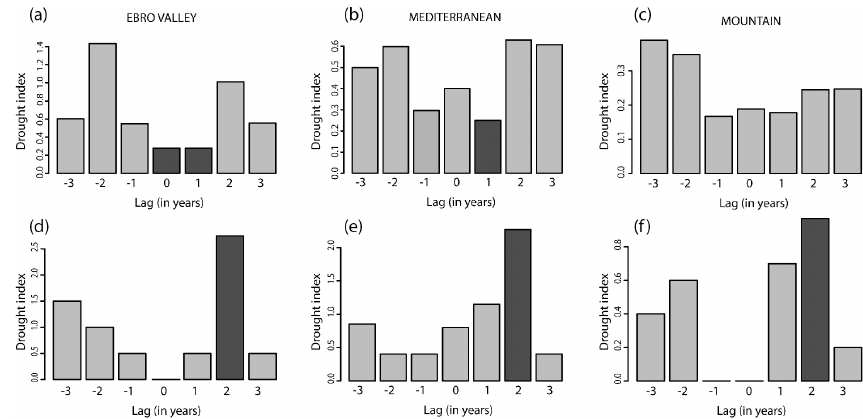
Figure 8. (a, b, c) Superposed epoch analysis (SEA) of the three regional drought indices, DIMOU (Mountain), DIEV (Ebro Valley) and DIMED (Mediterranean), with major volcanic events from Sigl et al. (2015). Black shadows show significance at p <0.01, i.e., significantly lower or higher drought index values after the volcanic event. (d, e, f) SEA of only the Tambora (1815) event showing a significant ( p <0.01) increase in the drought